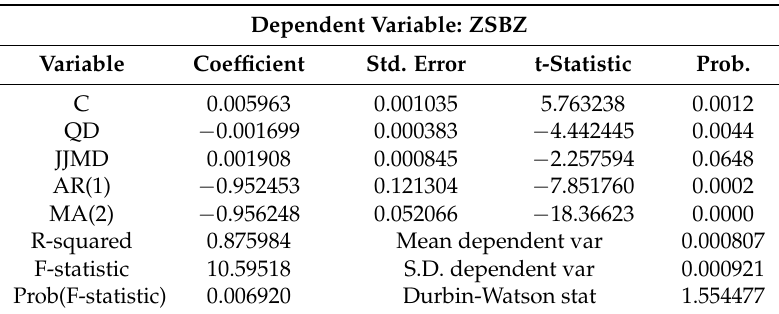
Table 14. Estimation of the results of the direct economic loss